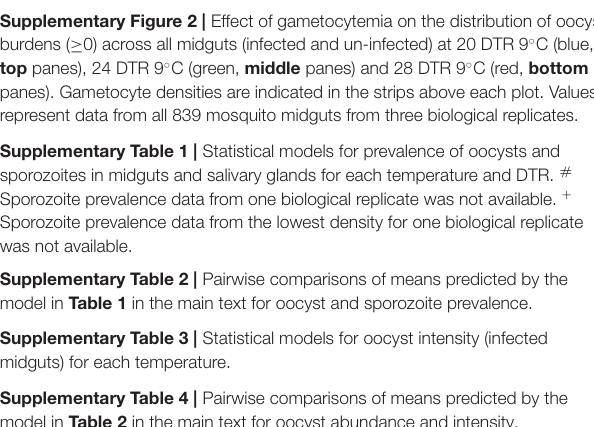
Supplementary Figure 1 | Effect of gametocytemia on the distribution of oocyst burdens in infected midguts at the three temperature regimes depicted in the respective panes. Each box represents the interquartile range, with the line within each box indicating median oocyst intensities, bounded by the 25th and 75th percentile values. Error bars represent maximum and minimum values from the interquartile range, with the dots representing outliers. Data were aggregated from the three biological replicates. Supplementary Figure 2 | Effect of gametocytemia on the distribution of oocyst burdens ( ≥ 0) across all midguts (infected and un-infected) at 20 DTR 9 ◦ C (blue, top panes), 24 DTR 9 ◦ C (green, middle panes) and 28 DTR 9 ◦ C (red, bottom panes). Gametocyte densities are indicated in the strips above each plot. Values represent data from all 839 mosquito midguts from three biological replicates. Supplementary Table 1 | Statistical models for prevalence of oocysts and sporozoites in midguts and salivary glands for each temperature and DTR. # Sporozoite prevalence data from one biological replicate was not available. + Sporozoite prevalence data from the lowest density for one biological replicate was not available. Supplementary Table 2 | Pairwise comparisons of means predicted by the model in Table 1 in the main text for oocyst and sporozoite prevalence. Supplementary Table 3 | Statistical models for oocyst intensity (infected midguts) for each temperature. Supplementary Table 4 | Pairwise comparisons of means predicted by the model in Table 2 in the main text for oocyst abundance and